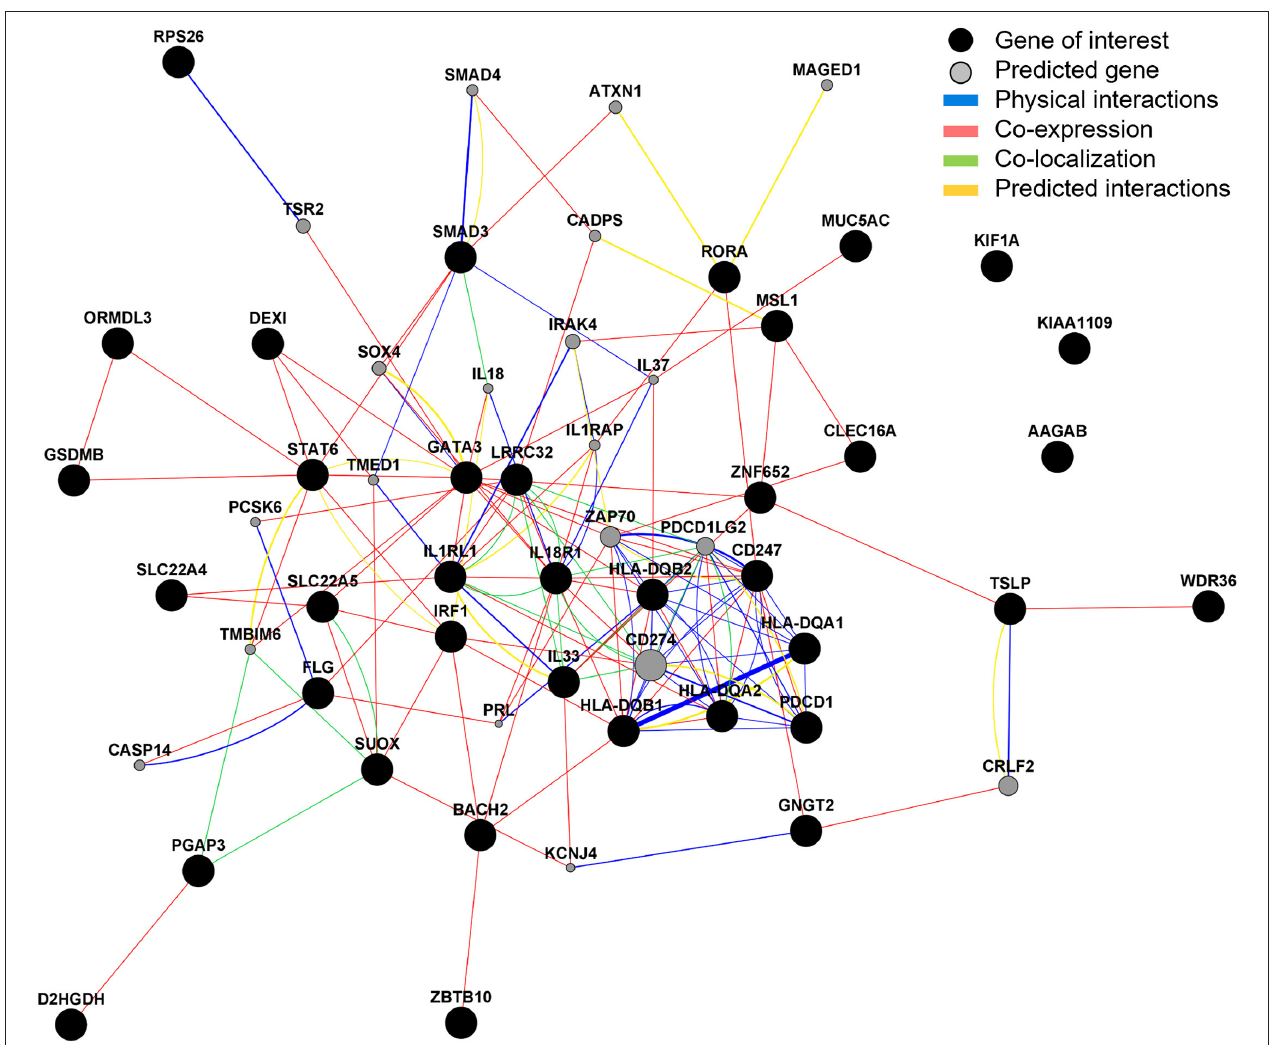
FIGURE 8 | Gene interaction analysis. GeneMANIA was used to explore and predict gene interactions. Black circles represent inputted candidate genes and gray circles are predicted genes (selected to show top 20 with strongest predicted association). The area of the gray circle represents prediction scores and thickness of line represent interaction scores, with a larger area/thicker line representing stronger